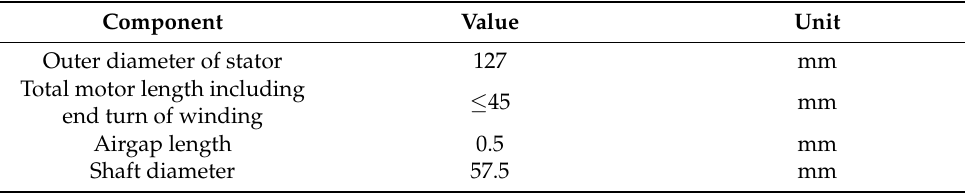
Figure 1. Structure of collaborative robot and motor space. Table 1. Size constraints of the motor for the collaborative robot.